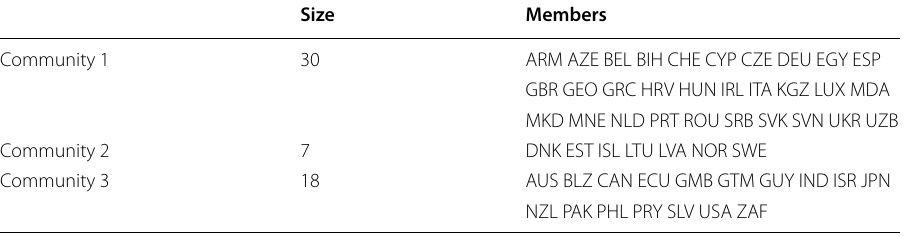
Table 12 Members of the communities detected by applying the Louvain method in 2019 Size